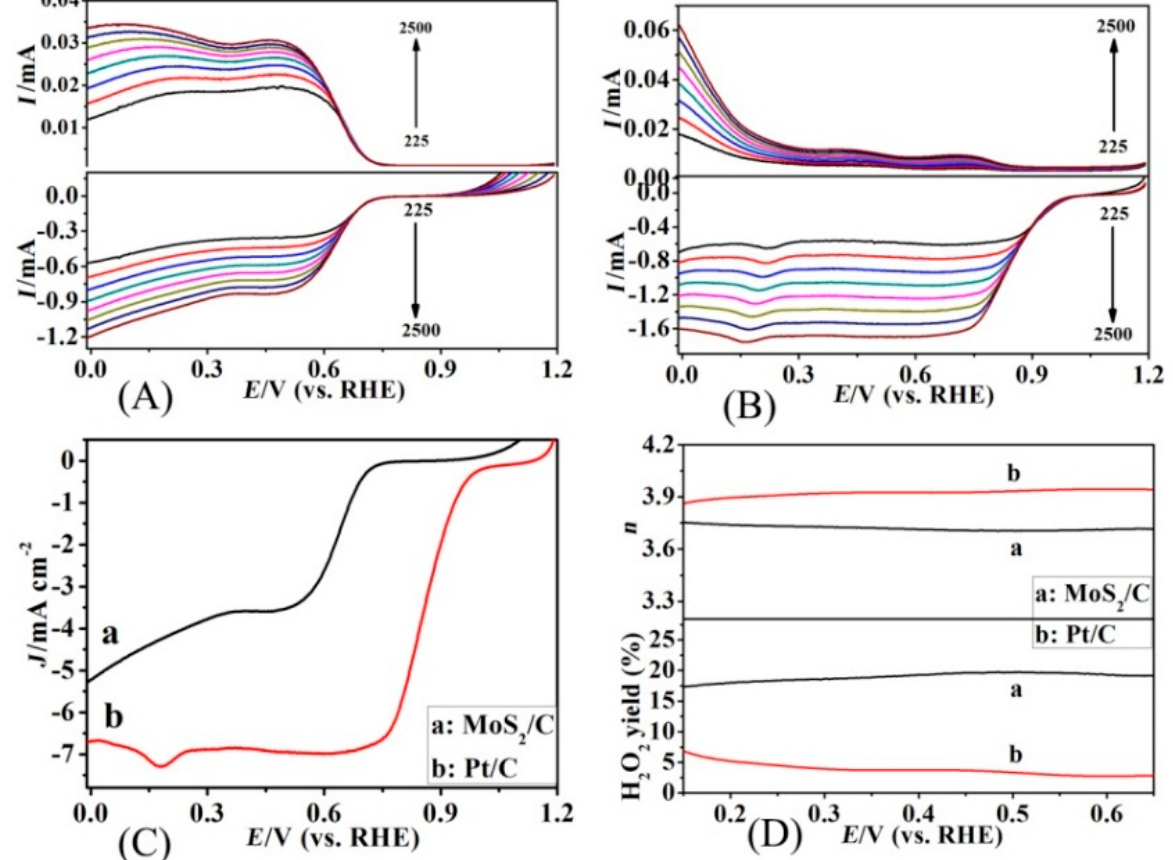
Figure 7. RRDE plots of different modified electrode: ( A ) MoS 2 /C-25, ( B ) Pt/C; RRDE plots of different modified electrode: ( C ) RDE plots of (a) MoS 2 /C-25 and (b) Pt/C in O 2 -saturated 0.1 M KOH solution at rotation rate of 1600 rpm; ( D ) H 2 O 2 yield measured and electron transfer number (n) of ( a ) MoS 2 /C-25 and ( b ) Pt/C in O 2 -saturated 0.1 M KOH at room temperature with rotation rate of 1600 rpm. Scan rate: 10 mVs − 1 .